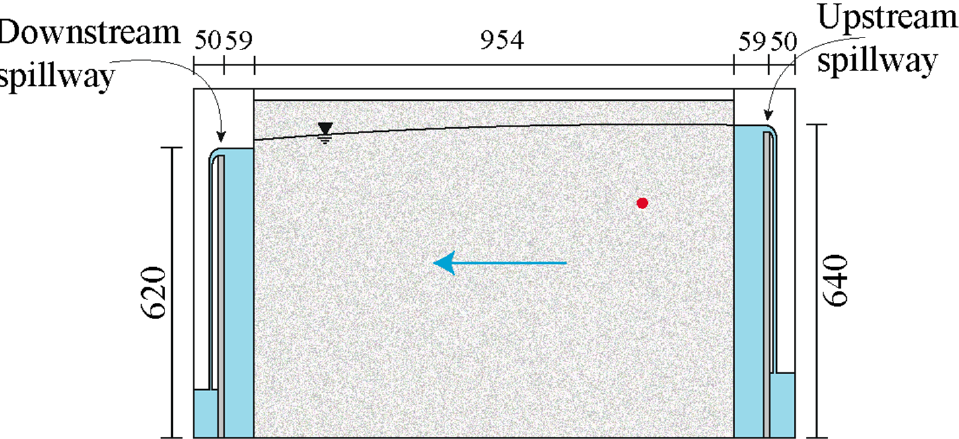
Figure 2. Sketch of the experimental device. Constant head boundaries upstream and downstream; the porous media was laterally confined by iron plates, and at the top, it is involved in the capillary fringe. The red dot is the source location. Dimensions are in mm. The blue arrow indicates the flow direction.